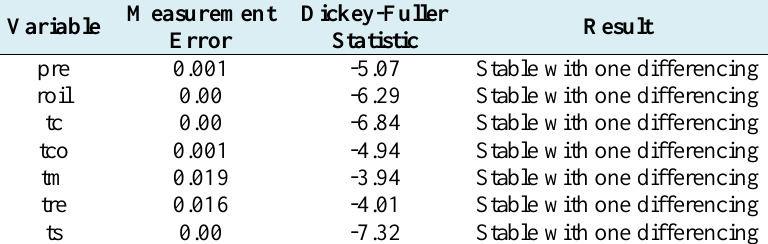
Table 2. Unit Root Test by Dickey-Fuller